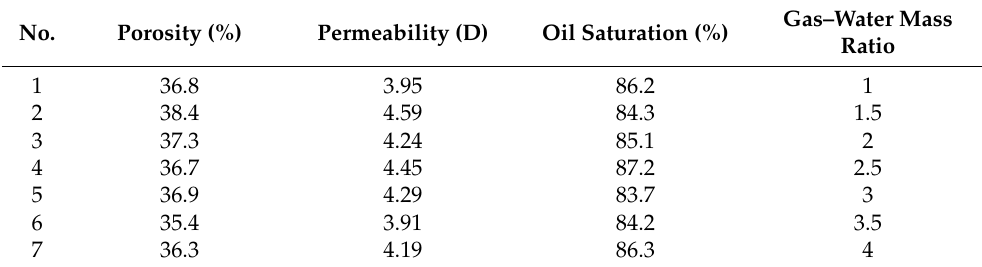
Table 15. One-dimensional experimental